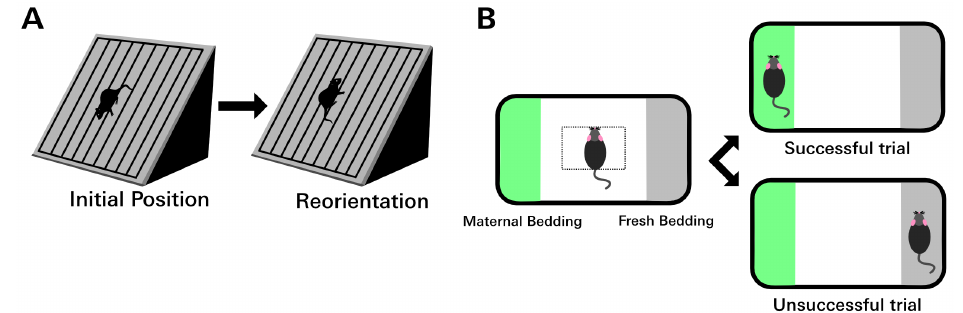
Figure 1. Behavior tests assessing motor and olfactory function. ( A ) In the rodent negative geotaxis assay, the animal is placed facing downhill on an incline. After PD7, young rodents will reflexively reorient to face uphill. The amount of time required to complete the 180 ◦ turn can be used to quantify a gross motor deficit. Failure was defined as taking longer than 60 s to complete the task. ( B ) In the olfaction discrimination assay, the animal is placed in the center of a rectangular area to either side of which is either maternal (home cage) bedding or fresh bedding. Between PD12 and PD14, rat pups have a strong preference for maternal bedding. Animals with olfactory deficits are slower to cross to the maternal side or may fail completely by choosing the fresh